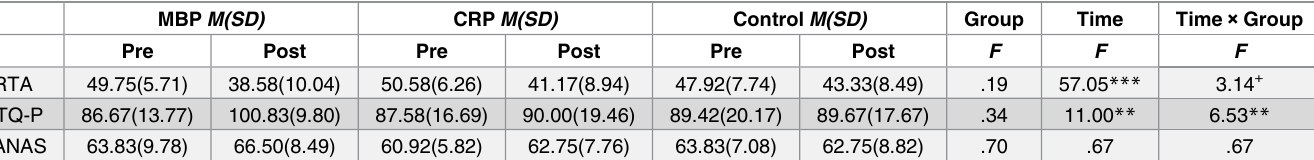
RTA, the main effect of Time was significant, F (1, 33) = 57.05, p < .001, η p2 = .63, and Group x